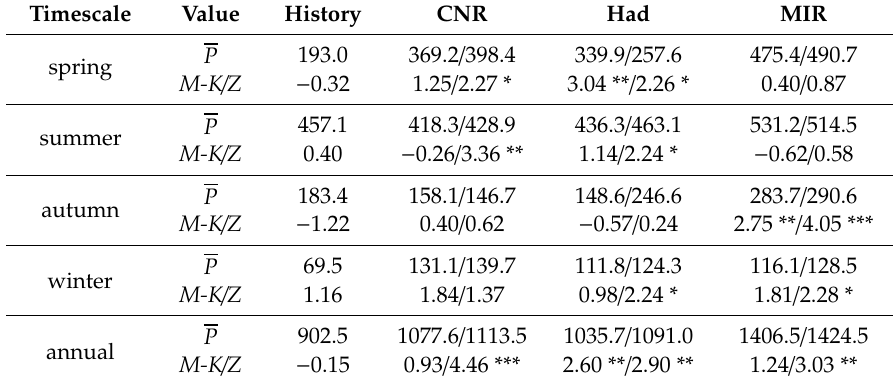
Table 3. The mean value of annual and seasonal precipitation ⎯ ( P/mm) and Mann-Kendall test values